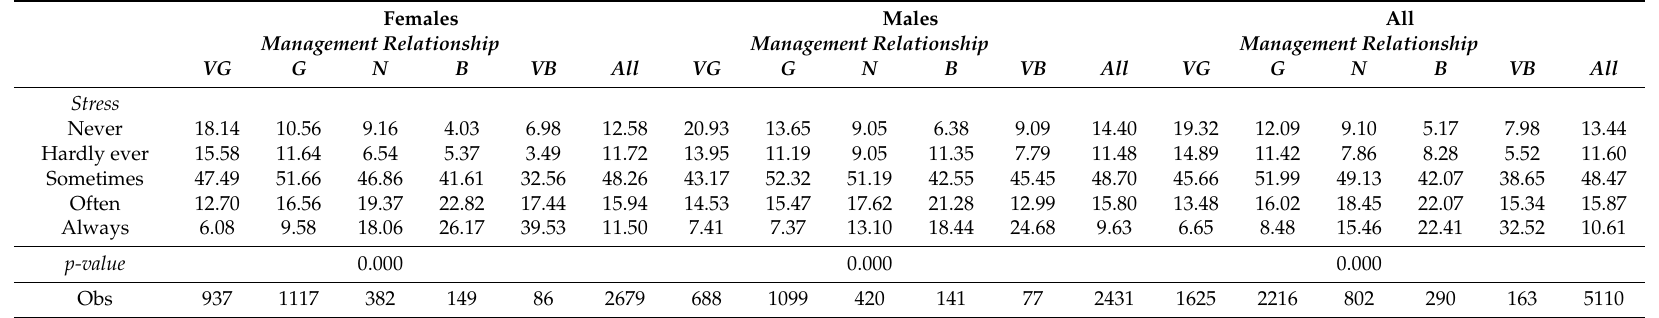
Table A2. Cross tabulations of stress and management relationship by gender and overall (%).